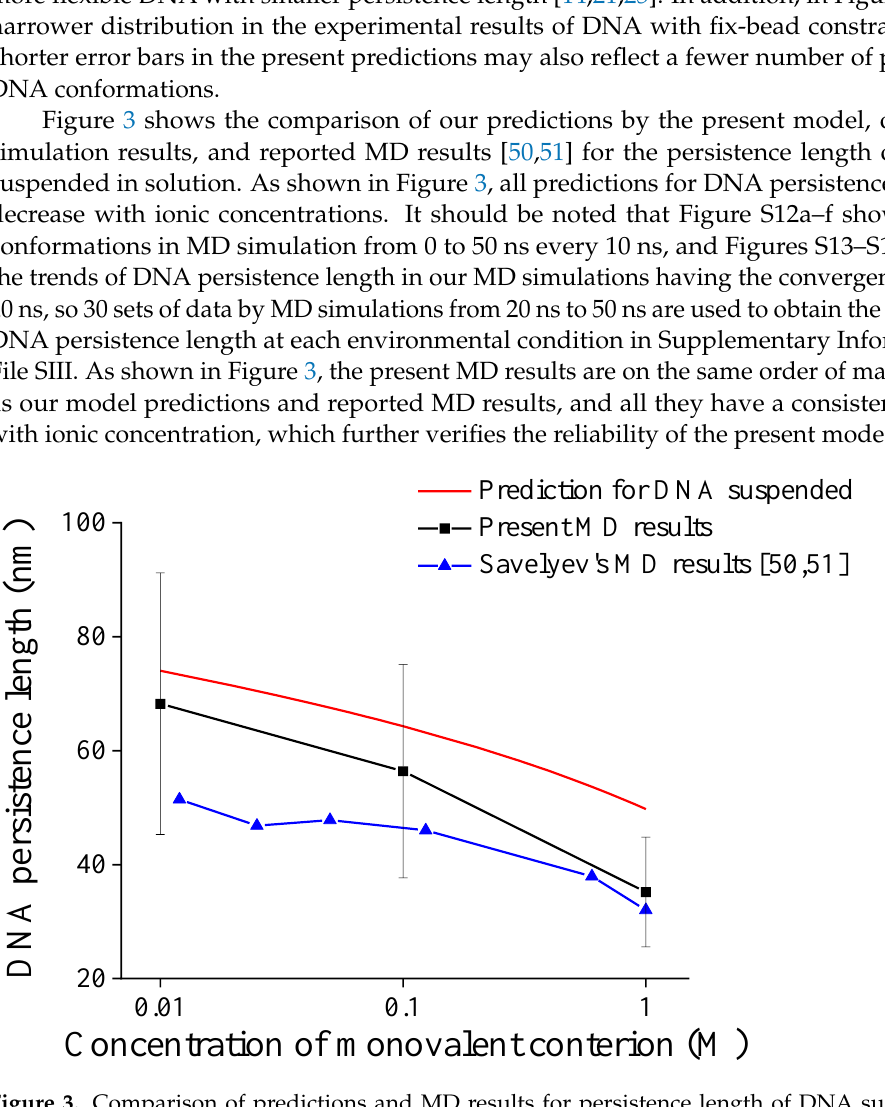
Figure 3. Comparison of predictions and MD results for persistence length of DNA suspended in solution.